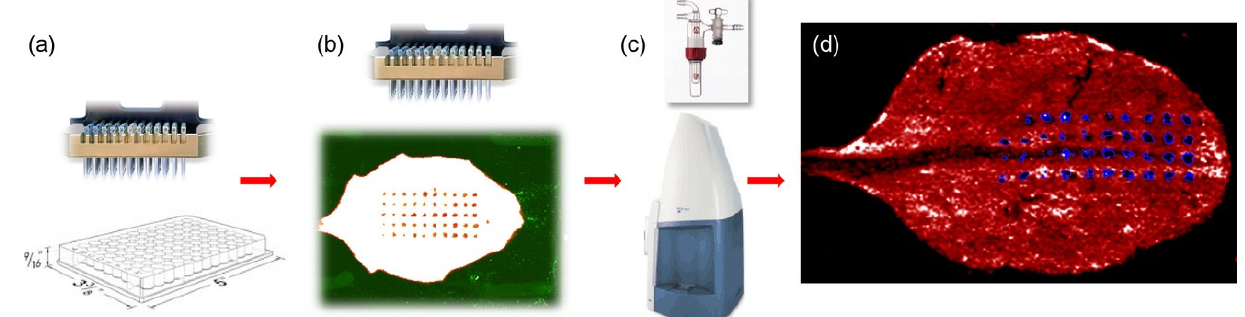
Figure 2. Quantification of glucosinolates on the surface of A. thaliana leaves. For the quantification study with MALDI-MSI: ( a ) A solution of internal standard (2-propenylglucosinolate) was mixed with a fluorescent dye and transferred with a pin array spotter to the leaf surface; ( b ) The quality of spotting was checked by a fluorescence scan; ( c ) The spotted leaves were covered with 9-aminoacridine matrix by sublimation and measured by MALDI-TOF mass spectrometry in the negative mode; ( d ) Collected data were analysed with Biomap software. Figure reproduced with permission from Shroff et al. [79].